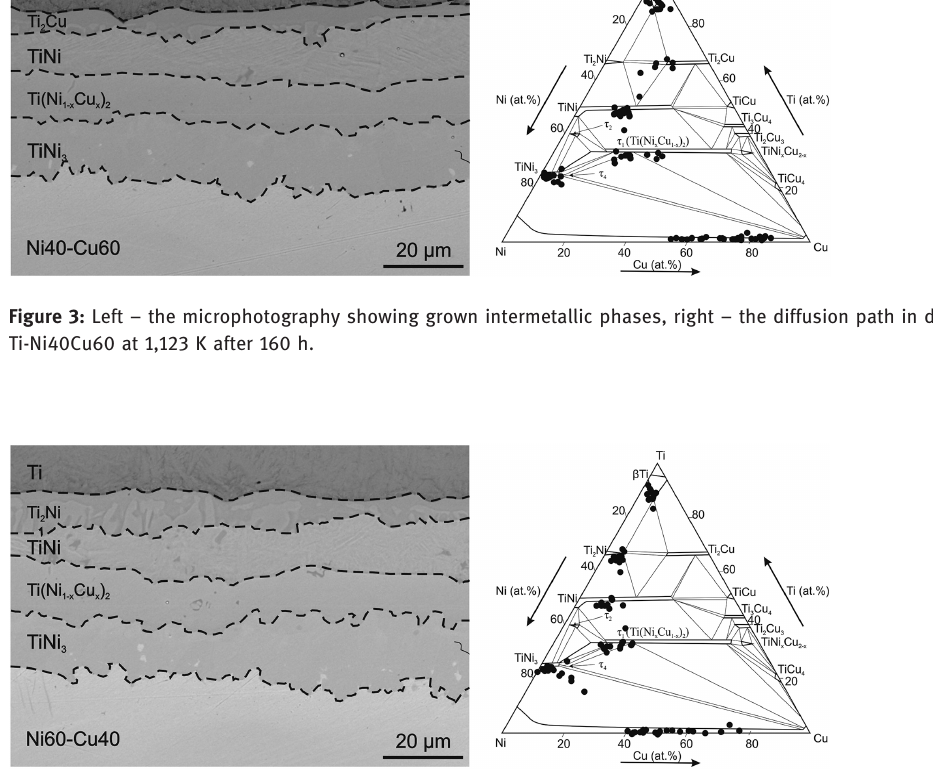
Figure 4: Left – the microphotography showing grown intermetallic phases, right – the diffusion path in diffusion couple experiment Ti-Ni60Cu40 at 1,123 K after 160 h.